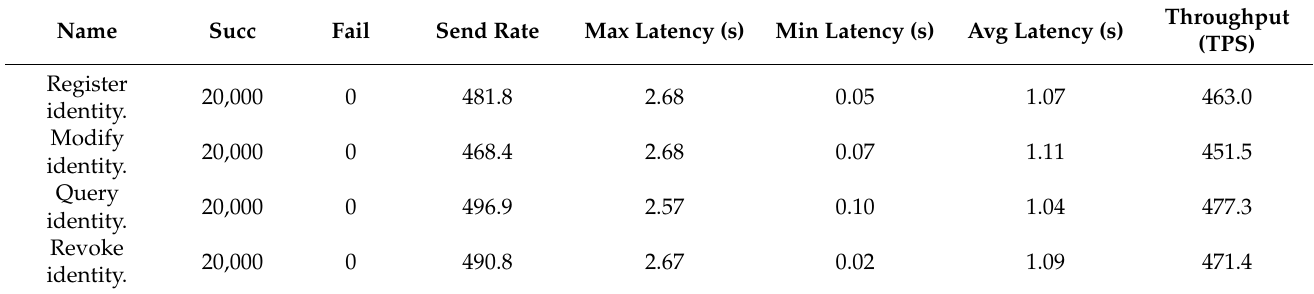
Table 6. Caliper report of Fabric performance under single computer.